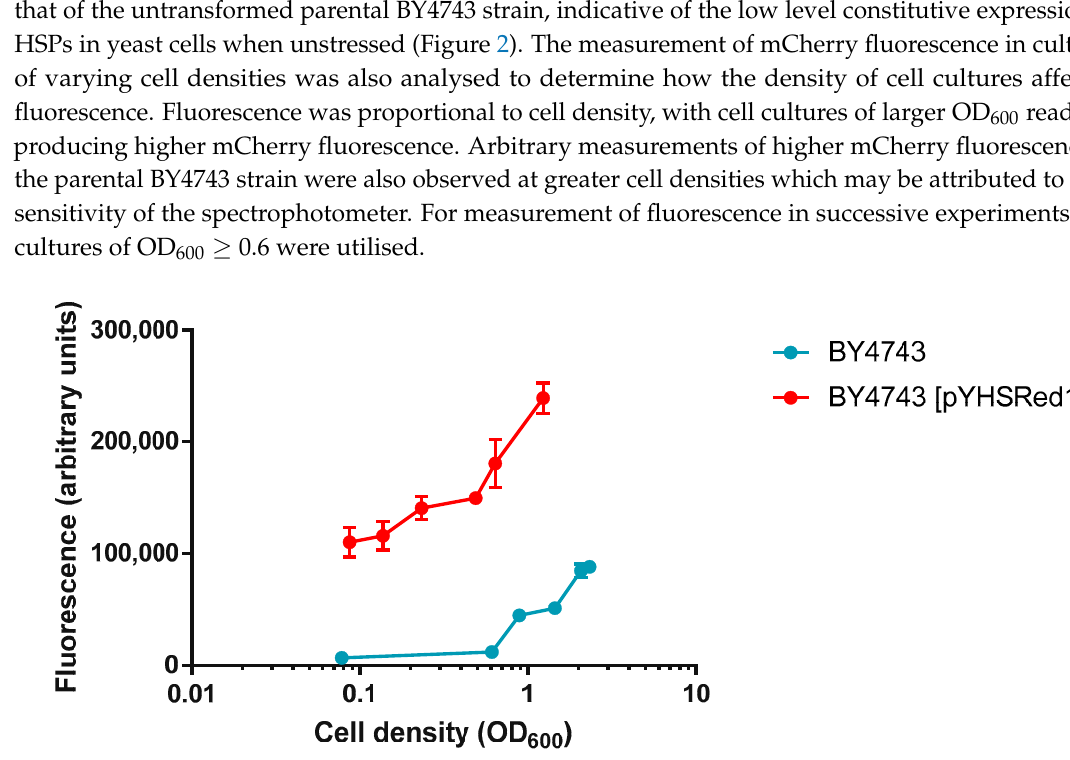
Figure 2. Comparison of basal levels of red fluorescence in BY4743 and BY4743 [pYHSRed1] in cultures of varying cell densities. Mean ± SEM of Data are shown as triplicate measurements.